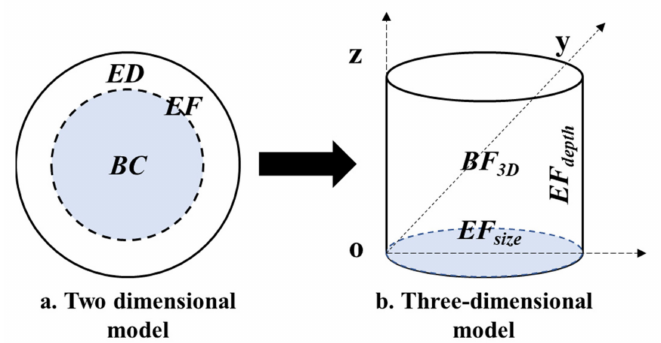
Figure 3. Evolution from two-dimensional model to three-dimensional